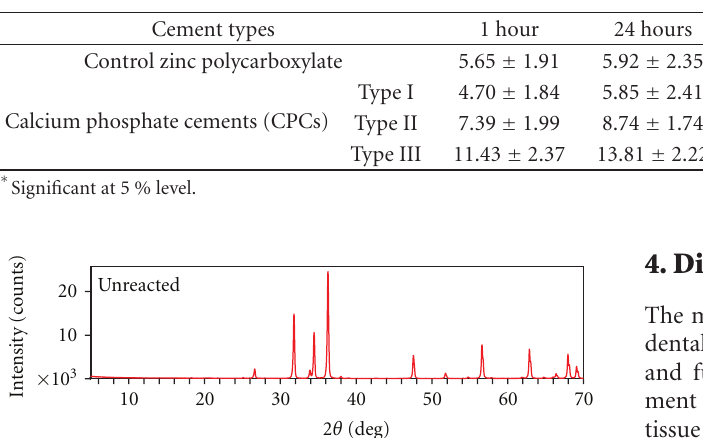
Table 4: Mean diametral tensile strength and standard deviation of zinc polycarboxylate cement and the three polymeric calcium phosphate cements (CPCs) in MPa.